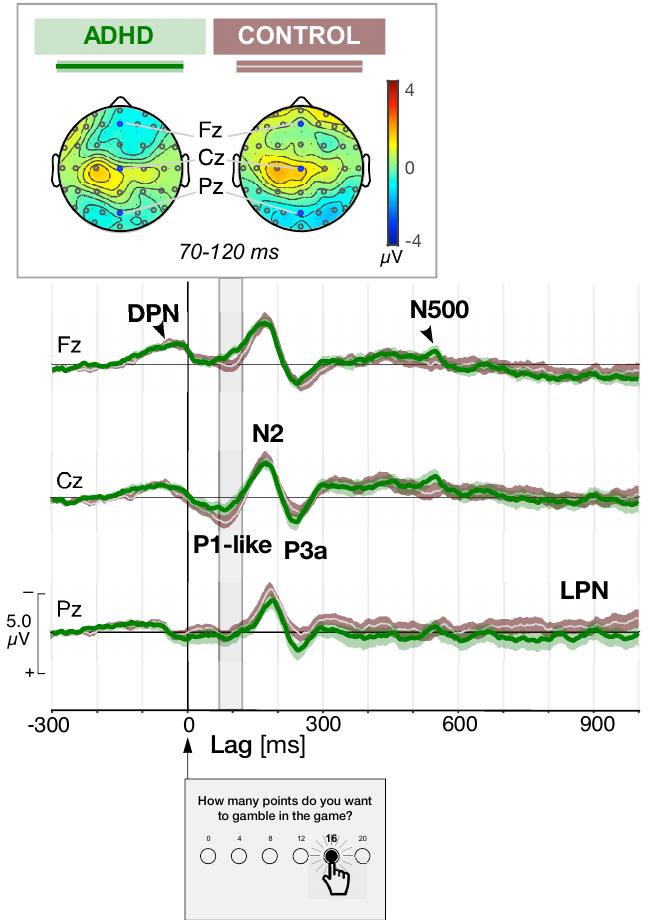
Figure 3. Grand average event-related potentials (ERPs) recorded before the working memory (WM) training at Fz, Cz and Pz sites triggered at lag 0, corresponding to button-click of the selected gamble, in attention deficit/hyperactivity disorder (ADHD) ( N = 28, green curves over light green shaded areas) and control participants ( N = 37, white curves over brown shaded areas) on a millisecond scale. The confidence interval (mean curve ± SEM) is shown by the shaded areas. We identified the decision preceding negativity (DPN), P1-like, N2, P3a, N500, and a late parietal negativity (LPN). Signal amplitude is scaled in microvolts ( µ V). The topographic maps on the top represent the distribution of the mean amplitude of the signal between 70 and 120 ms (estimated P1-like component) using a color-coded scale in µ